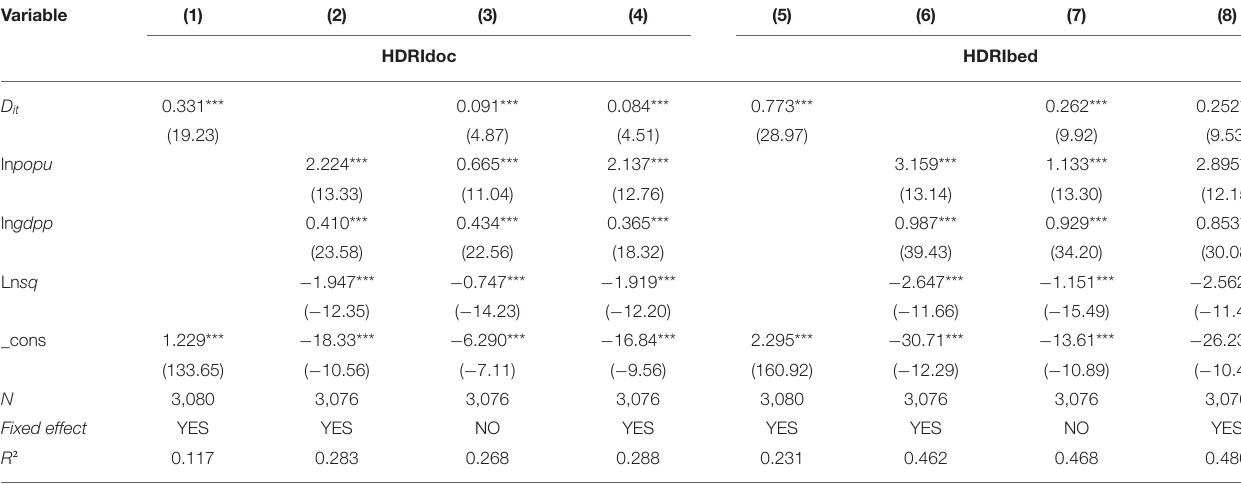
TABLE 3 | Estimation results of benchmark regression model.